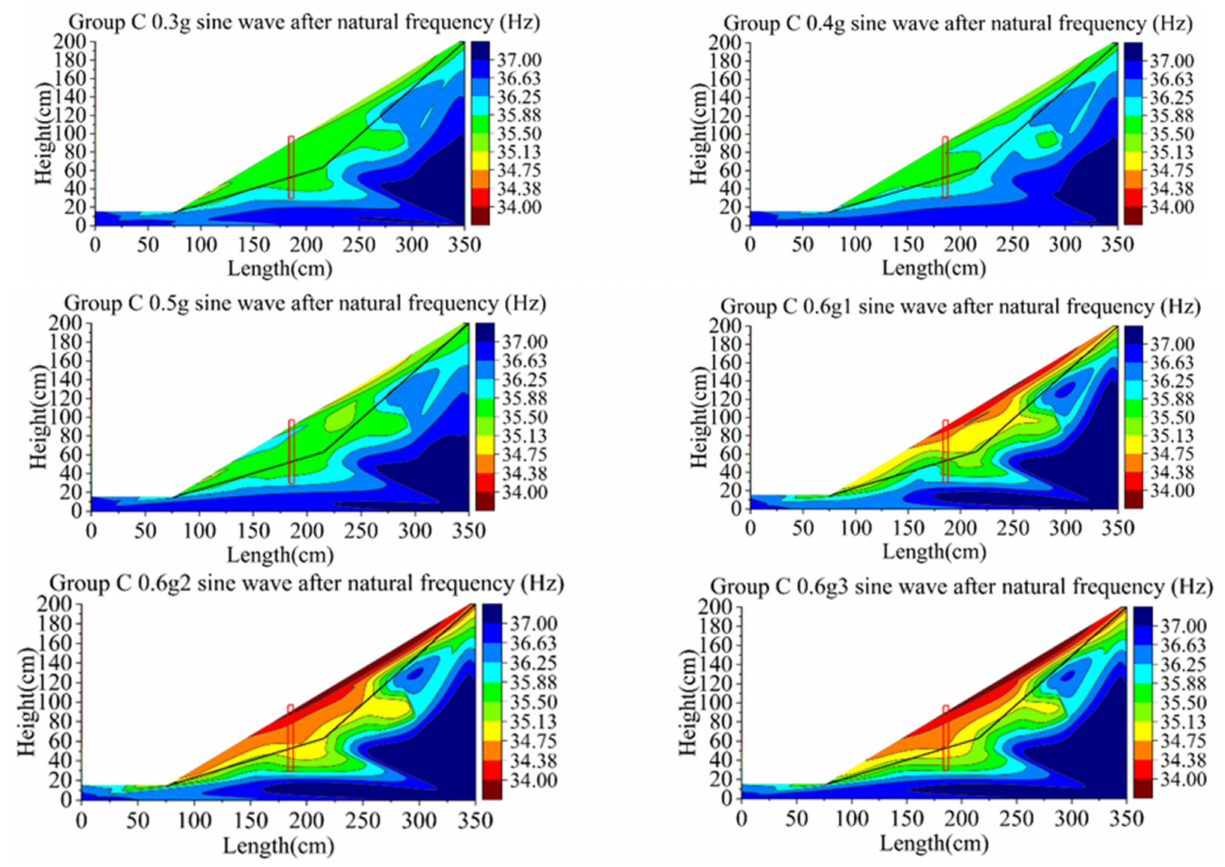
Figure 22. Contours of natural frequency of model